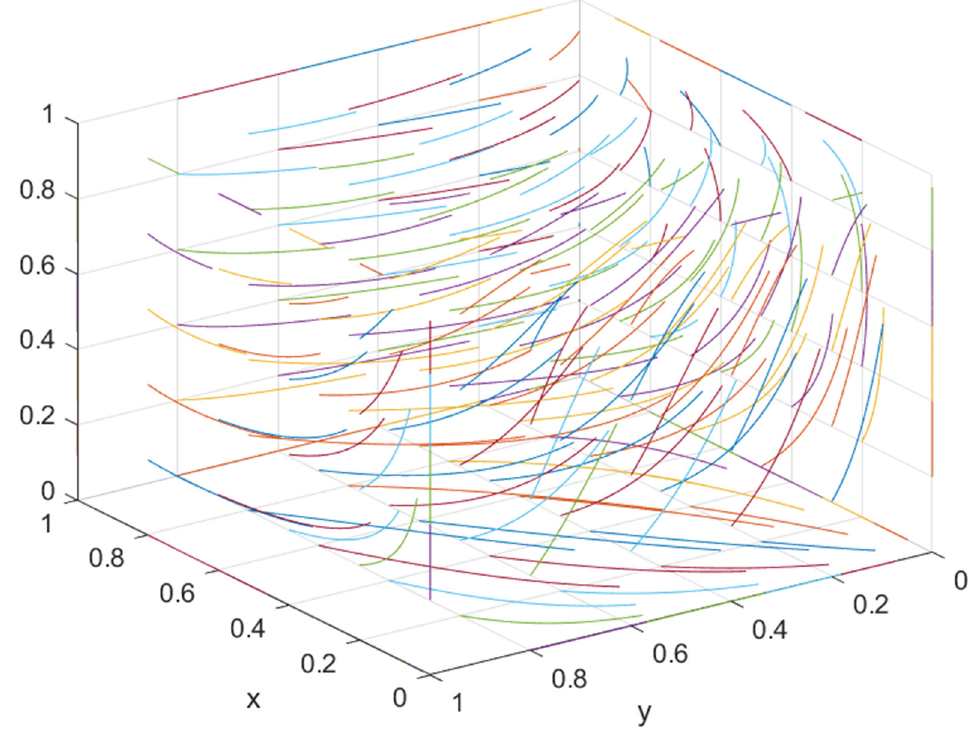
Figure 5. A5 = (1, 0, 1) evolution result.